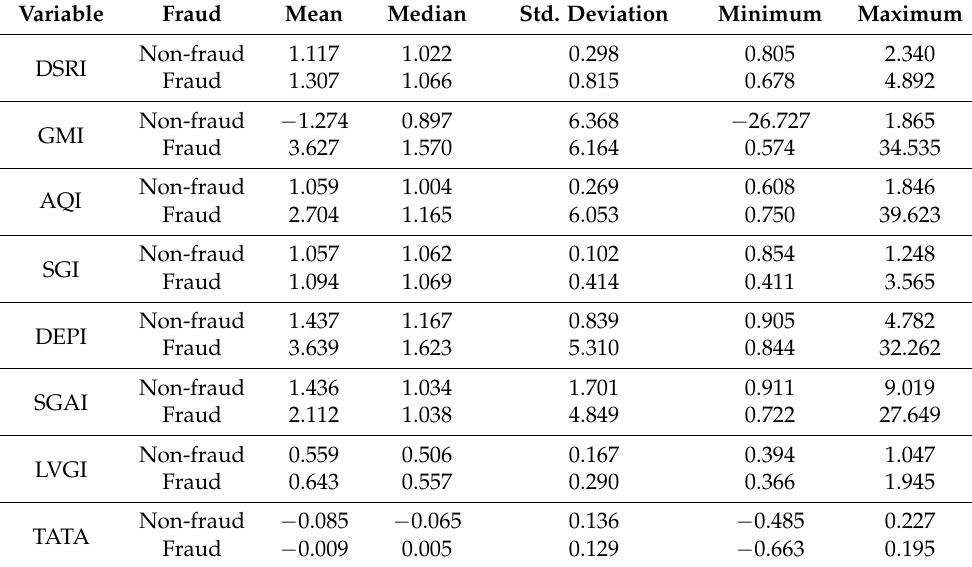
Table 1. Descriptive statistics of the Beneish score components on the fraud groups.